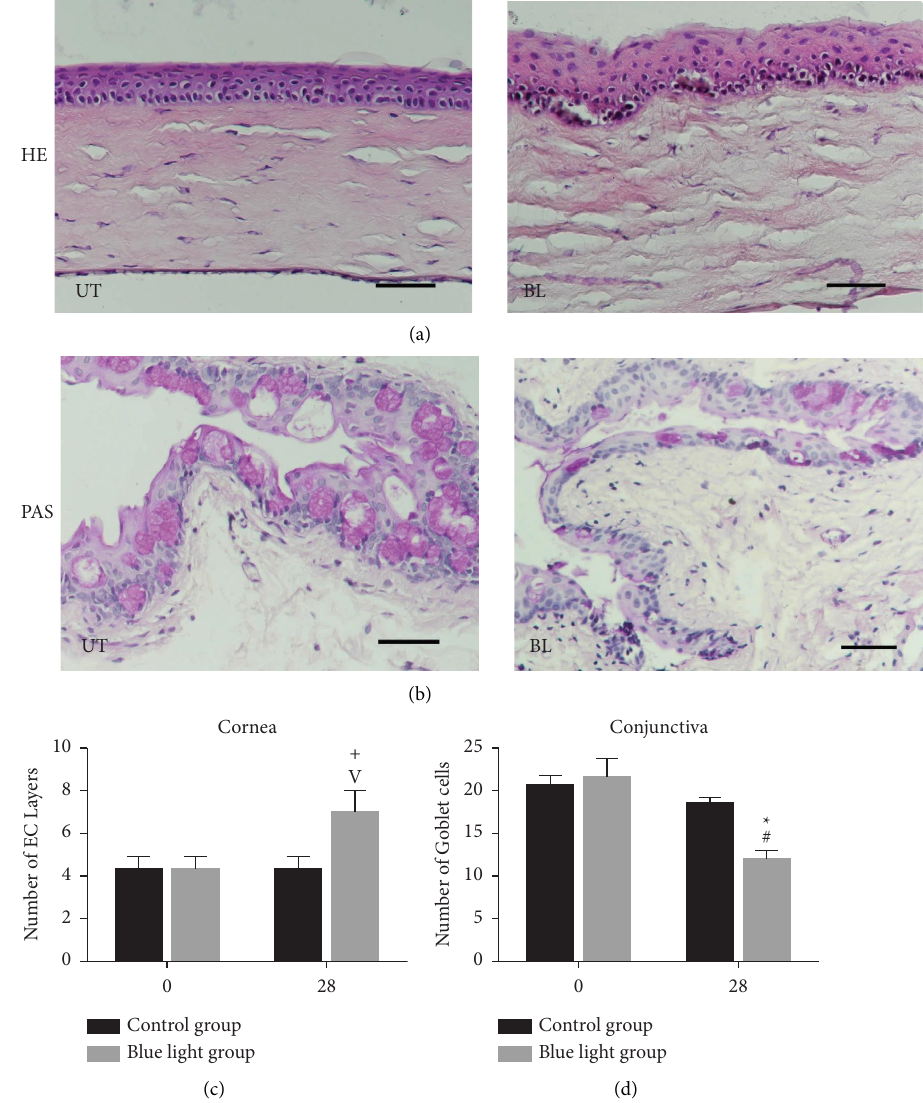
Figure 2: Histology analysis of corneal epithelium and goblet cells of the conjunctiva. (a, b) Representative images for PAS and HE staining are shown in the picture. In the blue light group, the arrangement of cells was disordered in each layer (right, a) with signifcantly increased epithelial cell layers (day 0 vs. day 28: + P < 0 . 05, (c) after irradiation for 28days. Furthermore, the number of goblet cells in the conjunctiva decreased signifcantly compared with the control group (c) and day 0 value (day 0 vs. day 28: # P < 0 . 01, (d). Control group vs. the blue light group: ∗ P < 0 . 01, v P < 0 . 05. Scale bars: 50 μ